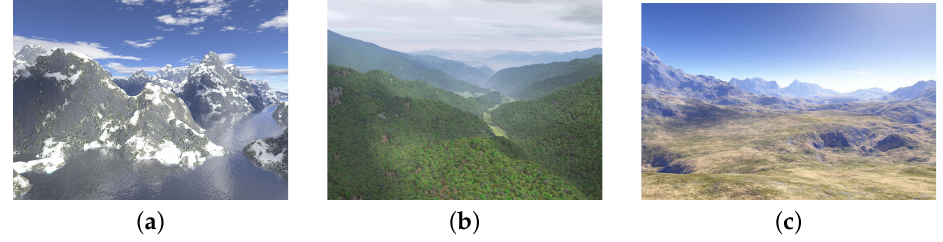
Figure 5. Computer-generated examples of ( a ) a fractal terrain, ( b ) a fractal woodhill, and ( c ) a fractal landscape. (Image source: https://en.wikipedia.org/wiki/Fractal_landscape, accessed on 22 June 2022).